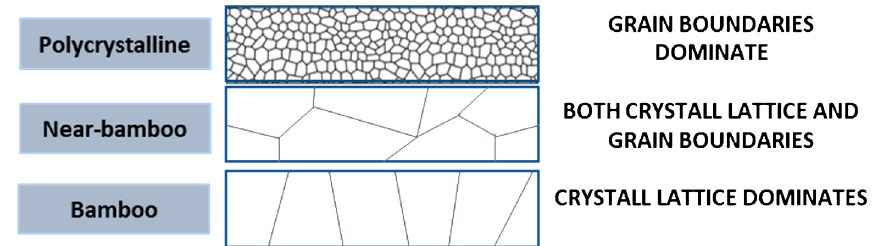
Figure 3. Different kinds of crystal structures which contribute to different preferred diffusion pathways during electromigration. Polycrystalline lattice has many small grain boundaries and therefore diffusion would be dominated by grain boundary diffusion although other types of diffusion also occur. On the other extreme, near-bamboo or bamboo structures will have lattice diffusion as its primary diffusion pathway, although near bamboo would also present grain boundary diffusion depending on the size of the line diameter with respect to the grain size.